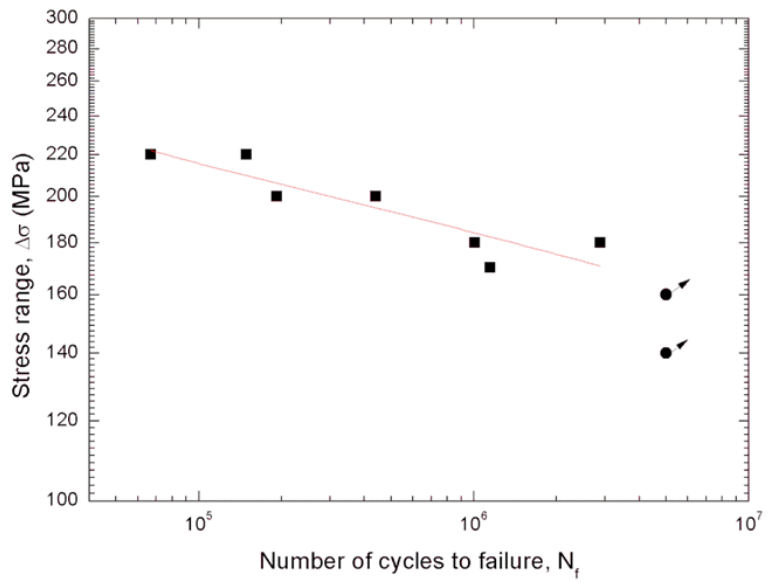
Figure 10. S-N curve of Ti6Al4V—Inconel 625 joints, reprinted from [43] with permission from Elsevier, 2022 year.